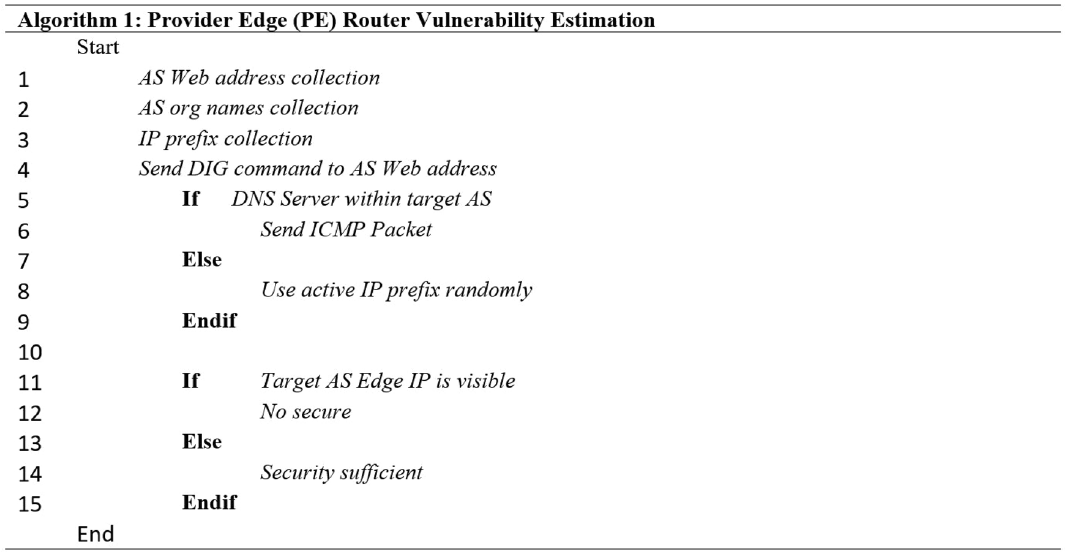
Figure 2. Proposed method for PE router vulnerability